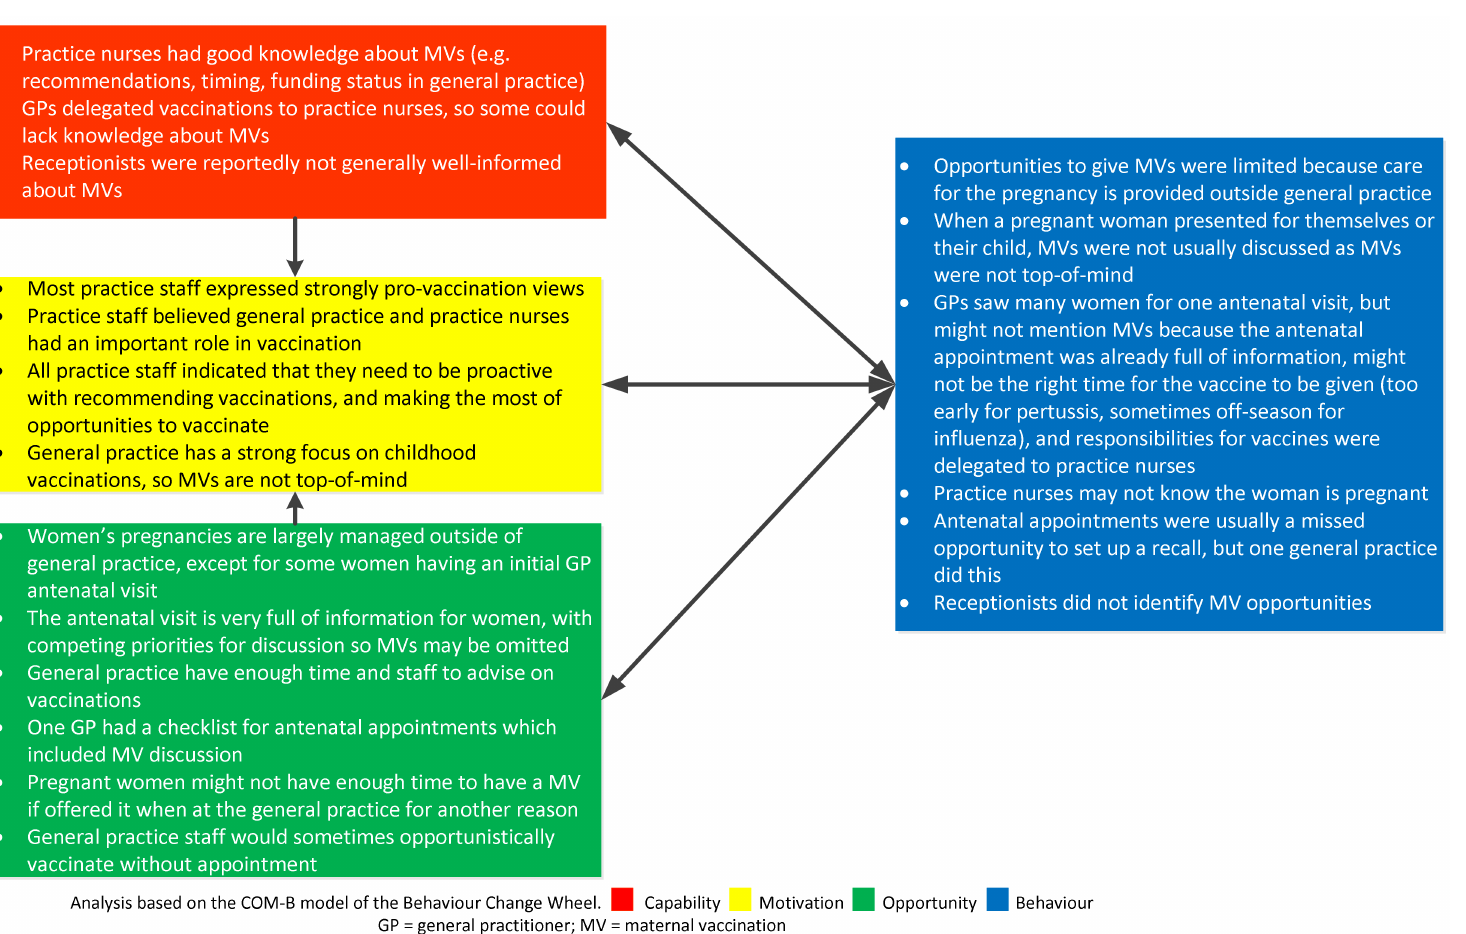
Figure 2. Factors affecting the recommendation and administration of maternal vaccines (MVs) for general practice staff using the COM-B